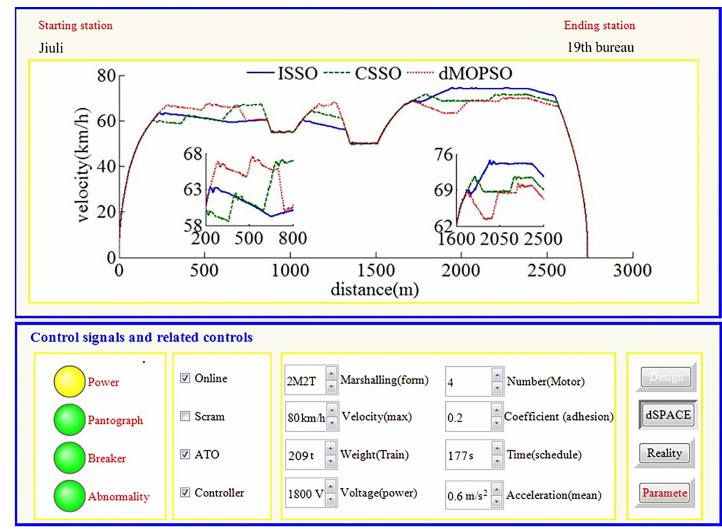
Figure 12. The HILS tracking control curves of different algorithms for Jinpu line No.1 in Dalian scenario.